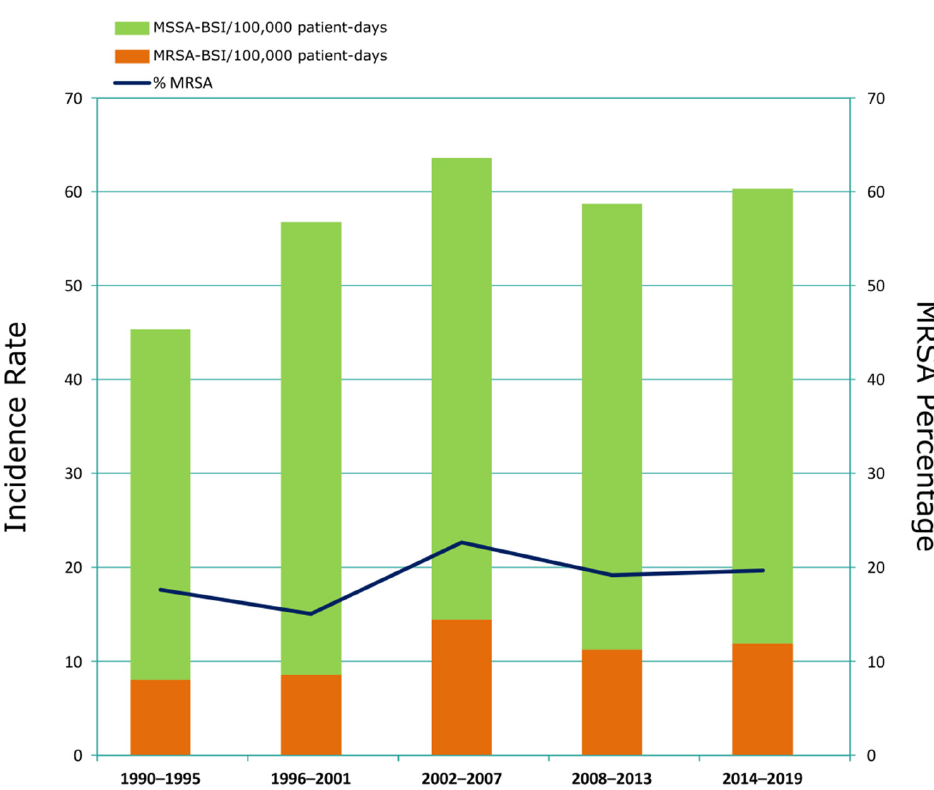
Figure 1. Evolution of MSSA- and MRSA-BSI over the study period. Incidence rates of MSSA- and MRSA-BSI (episodes per 100,000 patient-days) are shown in bars. The blue line shows the percentage of methicillin-resistant isolates.